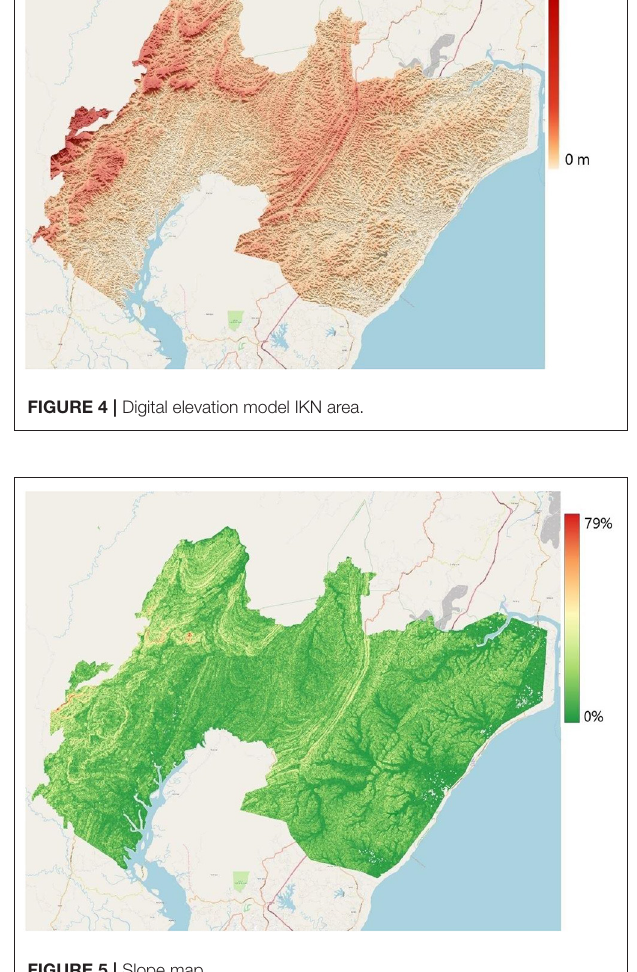
FIGURE 5 | Slope map.